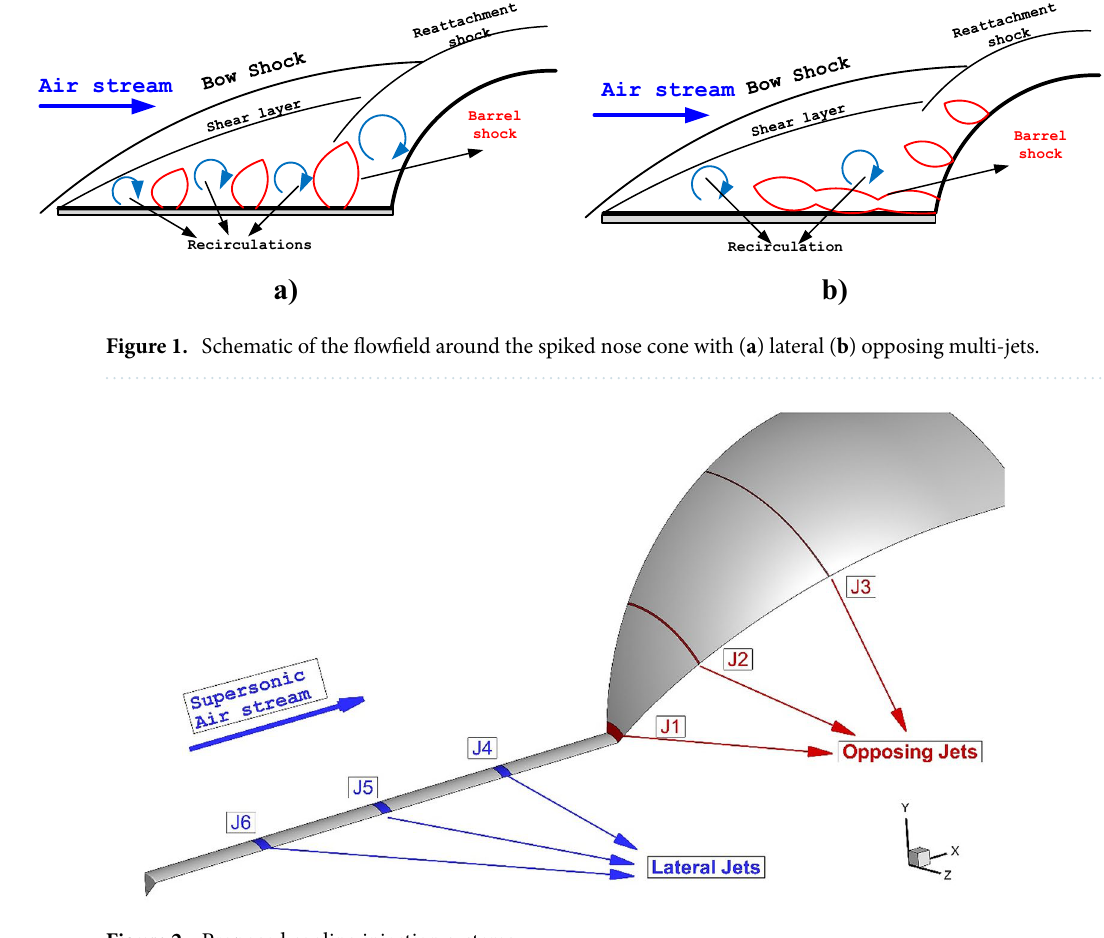
Figure 2. Proposed cooling injection